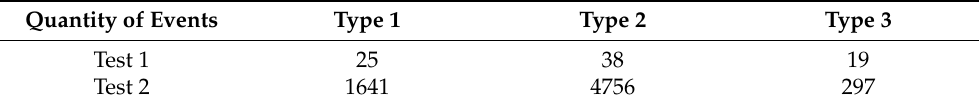
Table 4. Events quantity of each signal